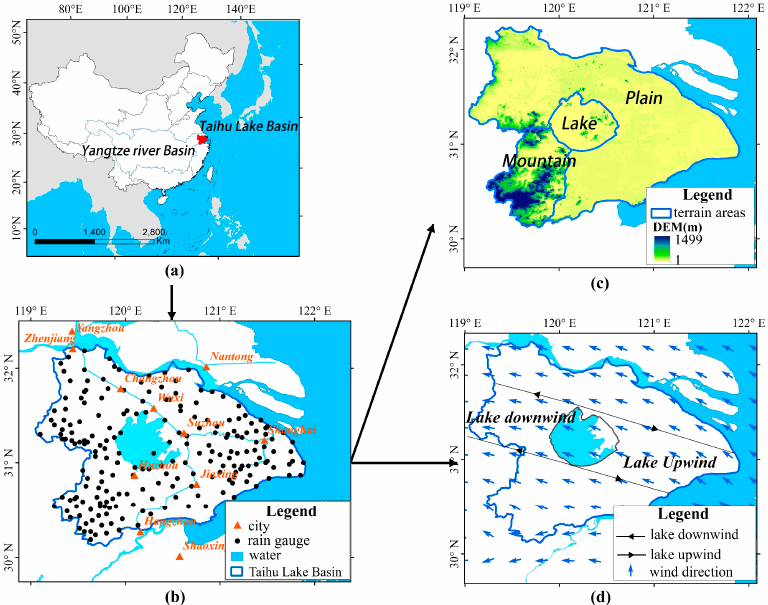
Figure 1. Geography overview of study area and rainfall gauge distribution. ( a ) Location map of Taihu Lake Basin in China; ( b ) DEM and terrain sub-areas of Taihu Lake Basin; ( c ) City and rain gauges distribution in the Taihu Lake Basin; ( d ) Average wind field distribution in the Taihu Lake Basin in flood season